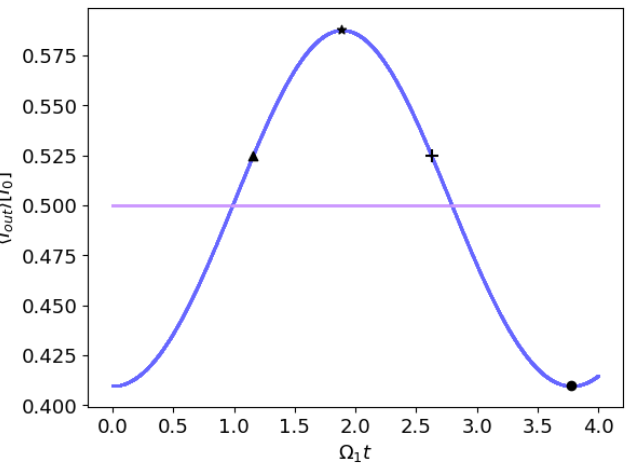
Figure 8. Average output power I − emitted on the left side of the fiber and I + on the right side for a system of two particles as a function of time. The initial condition is the same as in Figure 6. The blue line corresponds to the outgoing intensity to the left side (cid:104) I − (cid:105) and the purple line to the (constant) ( | 001 (cid:105) − i | 010 (cid:105) + i | 100 (cid:105) ) , ( (cid:63) ) to the outgoing intensity to right (cid:104) I + (cid:105) . ( (cid:78) ) corresponds to the state 1 √ 3 ( | 01 (cid:105) − | 10 (cid:105)| 0 (cid:105) , ( + ) to the state 1 √ ( −| 001 (cid:105) + i | 010 (cid:105) − i | 100 (cid:105) ) and ( · ) to −| 001 (cid:105) . The light state 1 √ 3 2 leaving the system thus contains information about the entangled motional states of the